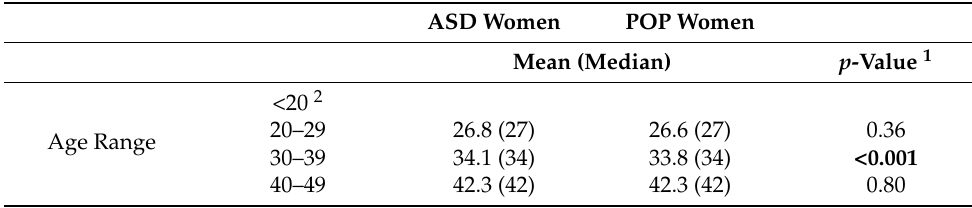
Table 4. Age Statistics on Women